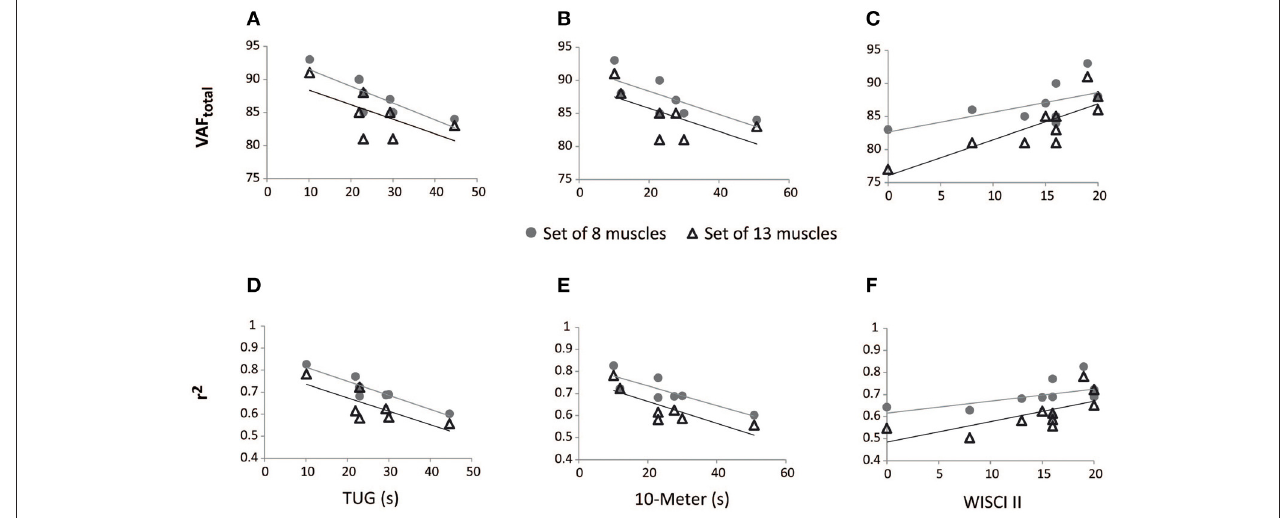
FIGURE 4 | Correlation between walking tests scores in iSCI patients and reconstruction goodness indexes at 42rpm, for the sets of 8 and 13 muscles. VAF total scores correlated negatively with TUG (A) and 10-m (B) tests; VAF total scores correlated positively with WISCI II (C) . r 2 scores correlated negatively with TUG (D) and 10-m (E) tests; r 2 scores correlated positively with WISCI II (F) .